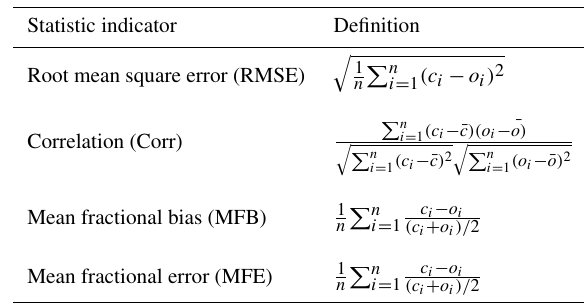
Table C1. Definitions of the statistics used in this work. (o i ) i and (c i ) i are the observed and the simulated concentrations at time and location i respectively. n is the number of data.